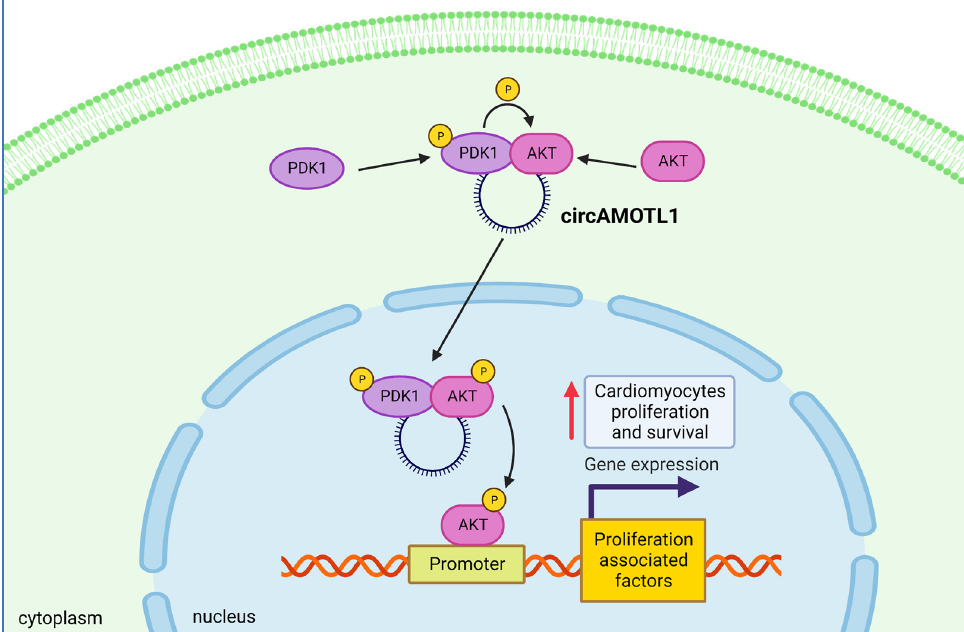
Figure 8. CircAMOTL1 is more highly expressed in neonatal hearts compared to mature hearts. In the cytoplasm of neonatal cardiomyocytes, circAMOTL1 serves as a docking platform for PDK1 and AKT. The formation of this ternary complex allows the phosphorylation of AKT by PDK1 and their nuclear translocation. In the nucleus, activated AKT positively regulates genes responsible for cardiomyocyte proliferation and regenerative abilities.